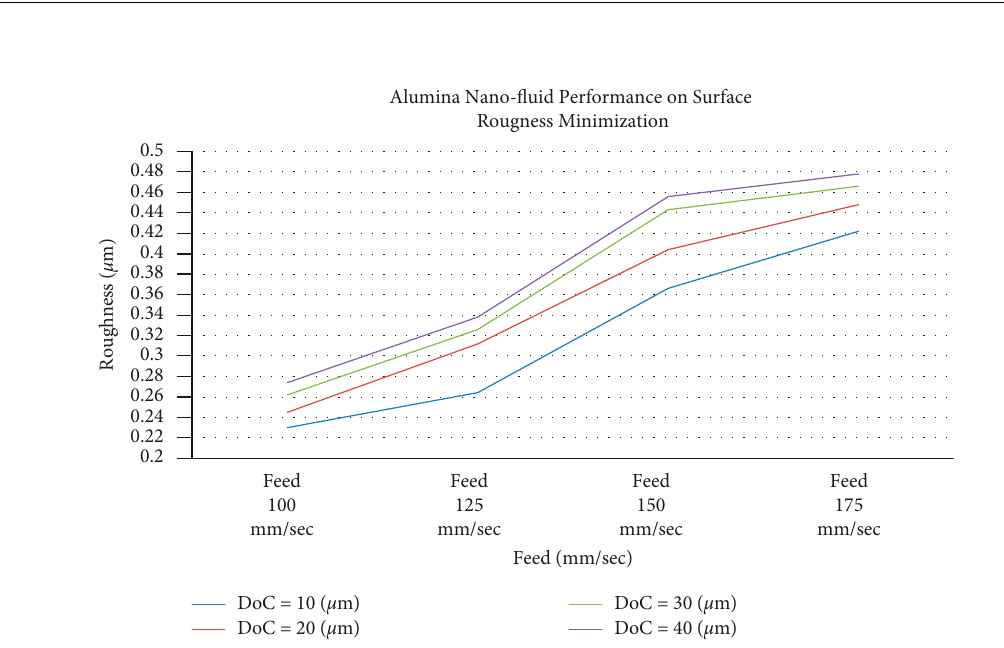
Figure 6: Alumina nanofluid performance on surface roughness minimization.